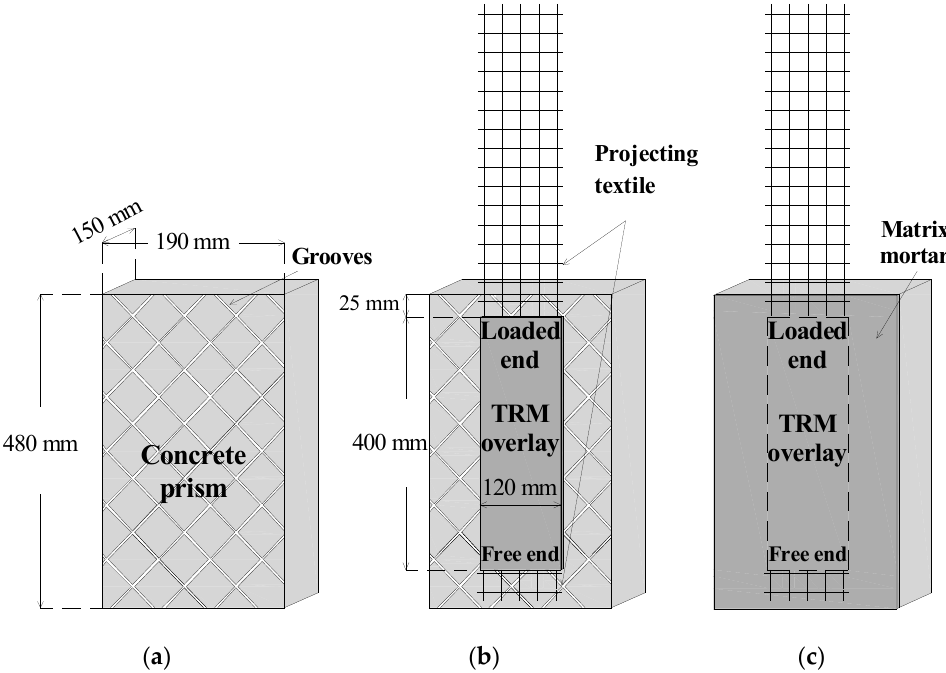
Figure 1. Different stages of specimen construction: ( a ) after surface treatment, ( b ) after application of the TRM strip, and ( c ) after complete coverage of its surface with mortar.